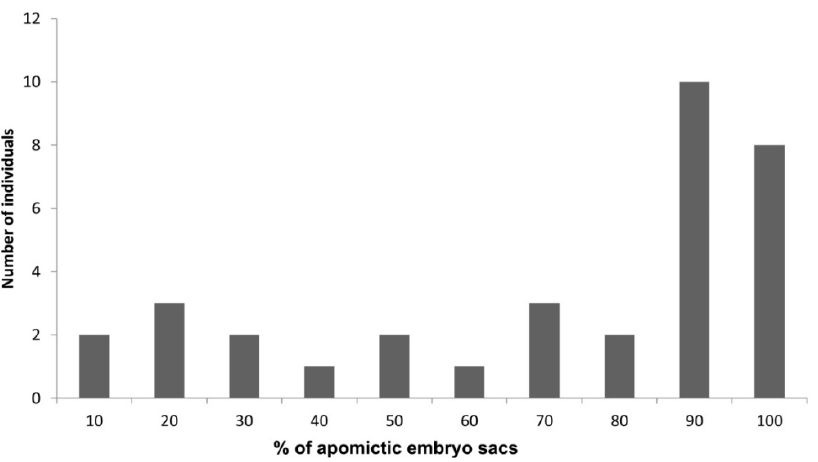
Figure 2. Percentage of apomictic embryo sacs in apomictic F1 hybrids individuals of the mapping population coming from the cross OTA-S (sex) × Don Walter (apo).